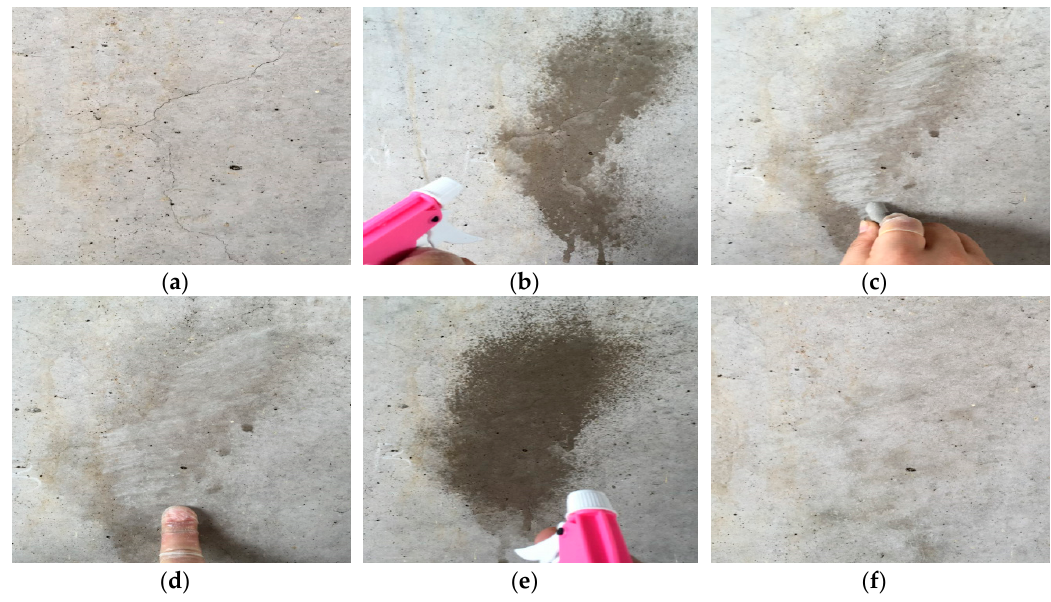
Figure 9. Repair procedures at the construction site. ( a ) The crack on the surface of the concrete structure at the site was selected for repair; ( b ) The crack surface was supplied by spraying water on it; ( c ) The crack surface was rubbed by using the crack repair stick first perpendicular to crack and then on its top; ( d ) The repaired surface was rubbed again by finger; ( e ) Finally, the repaired surface supplied with water again; ( f ) The repaired surface after 30 min.